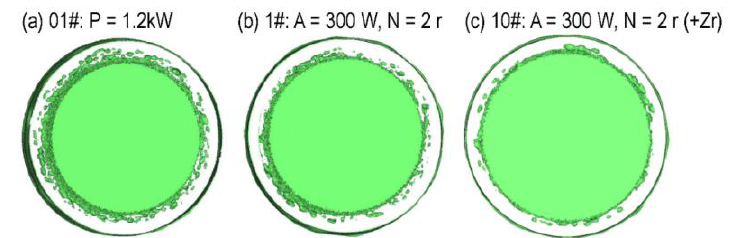
Figure 13. Reconstructed 3D transparent distribution of pores in the three joints achieved under ( a ) P = 1.2 kW; ( b ) average power = 1.2 kW, Amplitude = 300 W, frequency = 50 HZ, N = 2 cycles; and ( c ) average power = 1.2 kW, amplitude = 300 W, frequency = 150 HZ, N = 2 cycles, adding Zr, respectively. [11].